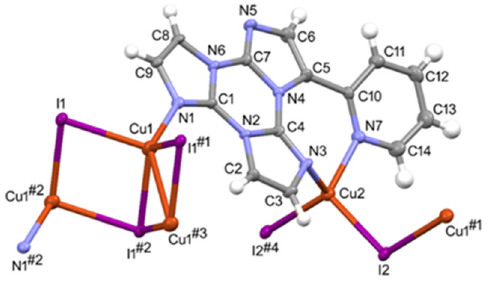
Figure 1. Crystal structure of 1 : portion of the crystal structure showing the coordination spheres of copper(I) atoms, with labelling scheme. Ellipsoids are drawn at 30% probability level. Symmetry codes: (#1): 1 + x, y, z; (#2): − x, − y, − z; (#3): 1 − x, − y, − z; (#4): 1 − x, y, z.